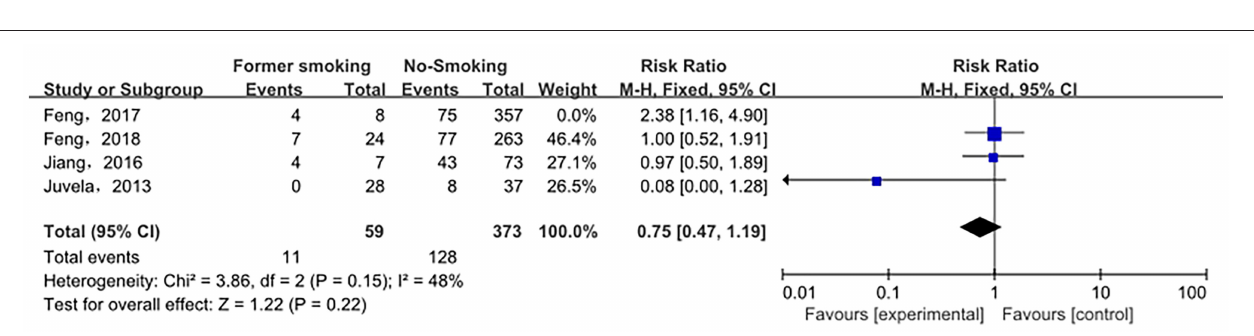
FIGURE 6 | A Forest plot of the former smoking and non-smoking groups after heterogeneous cohorts were removed by sensitivity analysis.